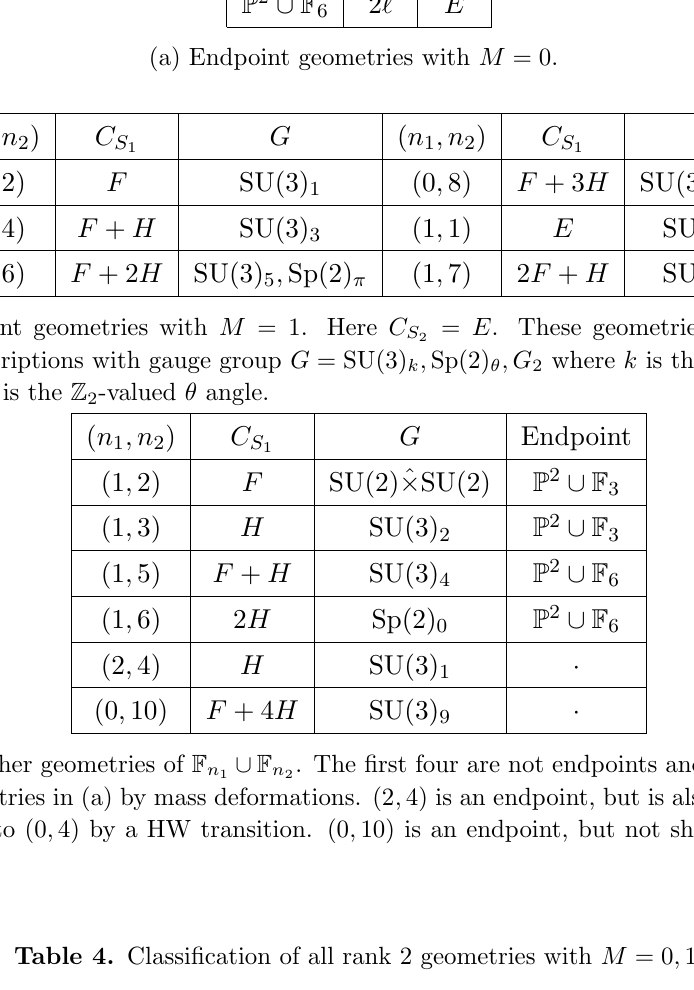
Table 4. Classi(cid:12)cation of all rank 2 geometries with M = 0 ;